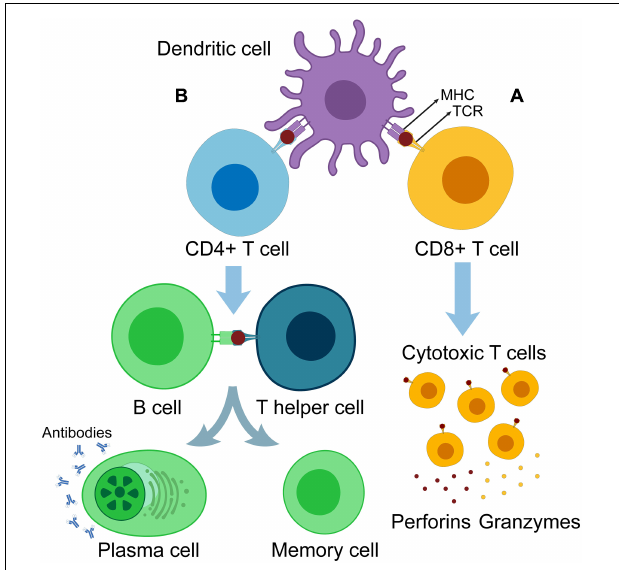
FIGURE 1 | Antigen cross-presentation and T-cell priming. (A) Dendritic cell primes CD8 + T cells. Primed CD8 + cells are differentiated into cytotoxic T cells producing perforins and granzymes. (B) DC primes CD4 + T cells. Primed CD4 + cells are differentiated into T helper cells, which in turn activate B cells and differentiate them into memory cells and antibody-producing plasma